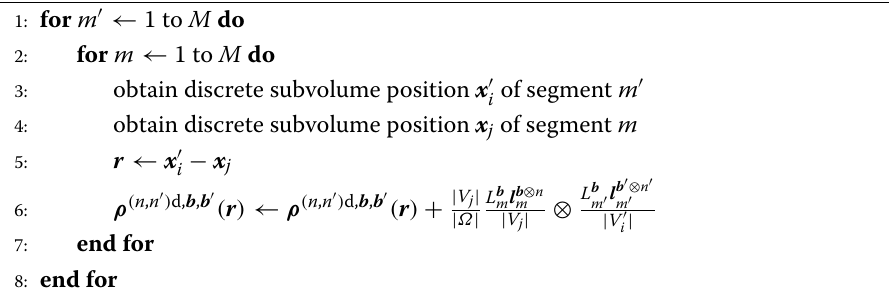
Algorithm 2 Calculation of discrete homogenized pair density tensors using